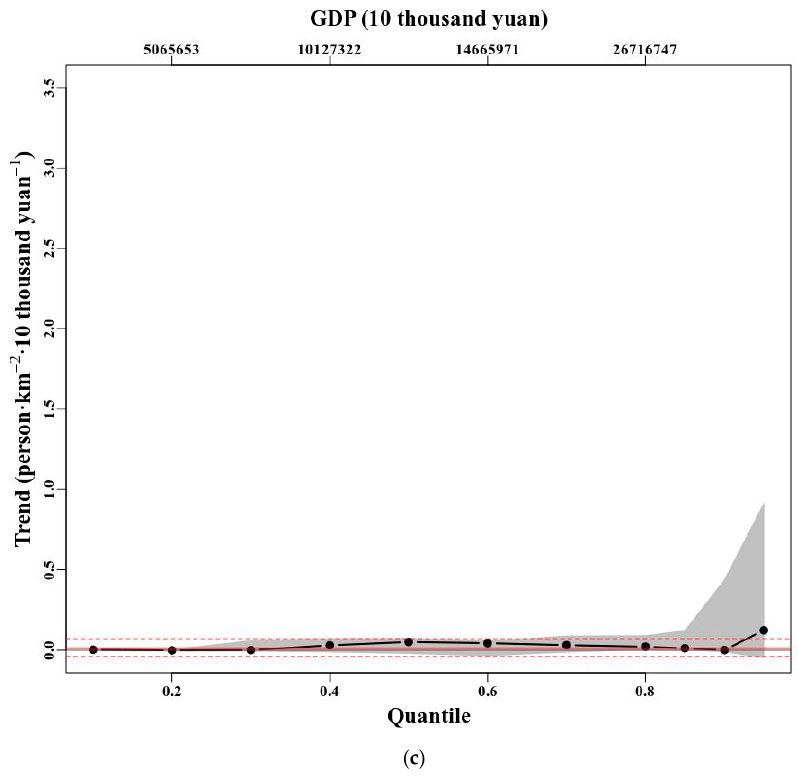
Figure 6. ( a ) Quantile regression slopes of the 0.1–0.95 quantiles of GDP in relation to population exposure to PM 2.5 on the grid-level spatial scale. ( b ) Quantile regression slopes of the 0.1–0.95 quantiles of GDP in relation to population exposure to PM 2.5 on the county-level spatial scales. ( c ) Quantile regression slopes of the 0.1–0.95 quantiles of GDP in relation to population exposure to PM 2.5 on the city-level spatial scale. Upper quantiles are displayed with smaller step length (such as 0.85, 0.9, 0.95).